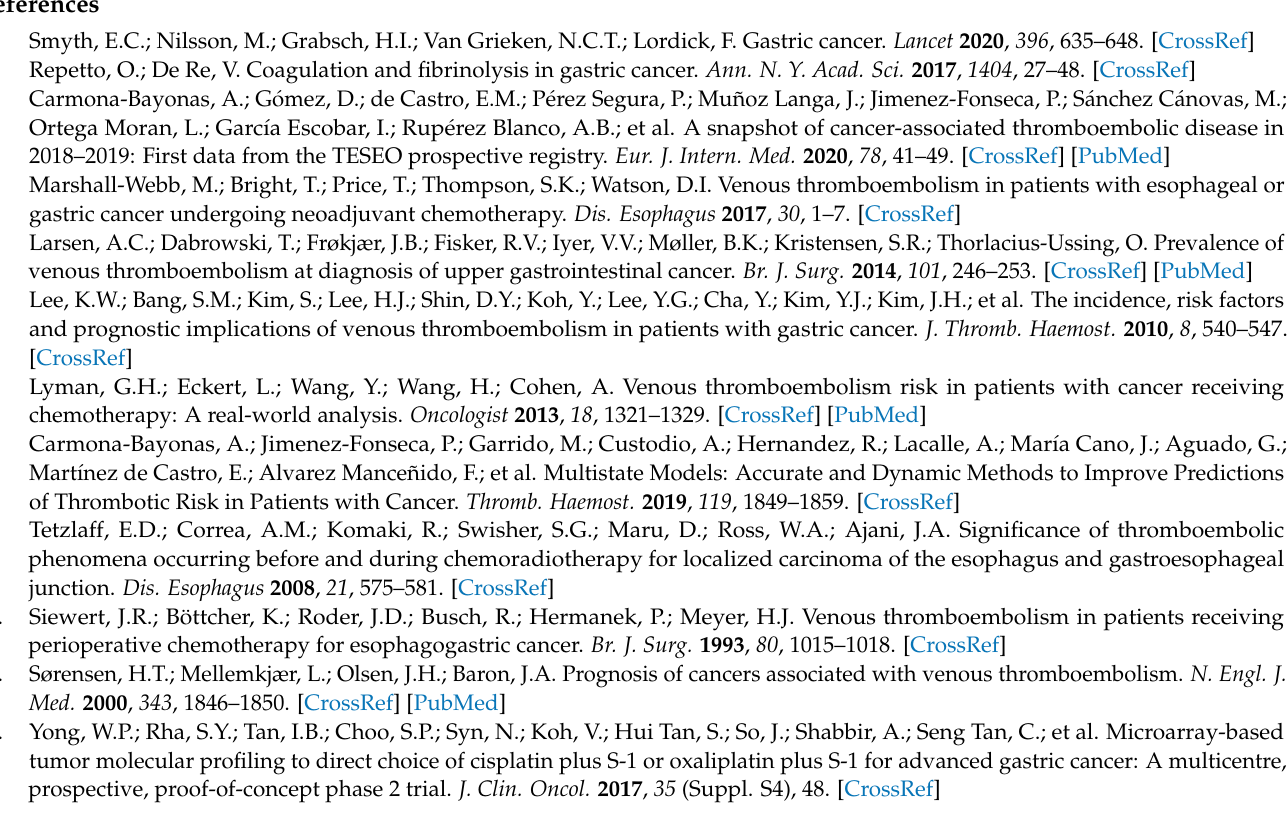
genes between patients with venous thromboembolism and controls in chromosomal instability tumors. Table S5: Differentially expressed genes between patients with venous thromboembolism and controls in genomically stable